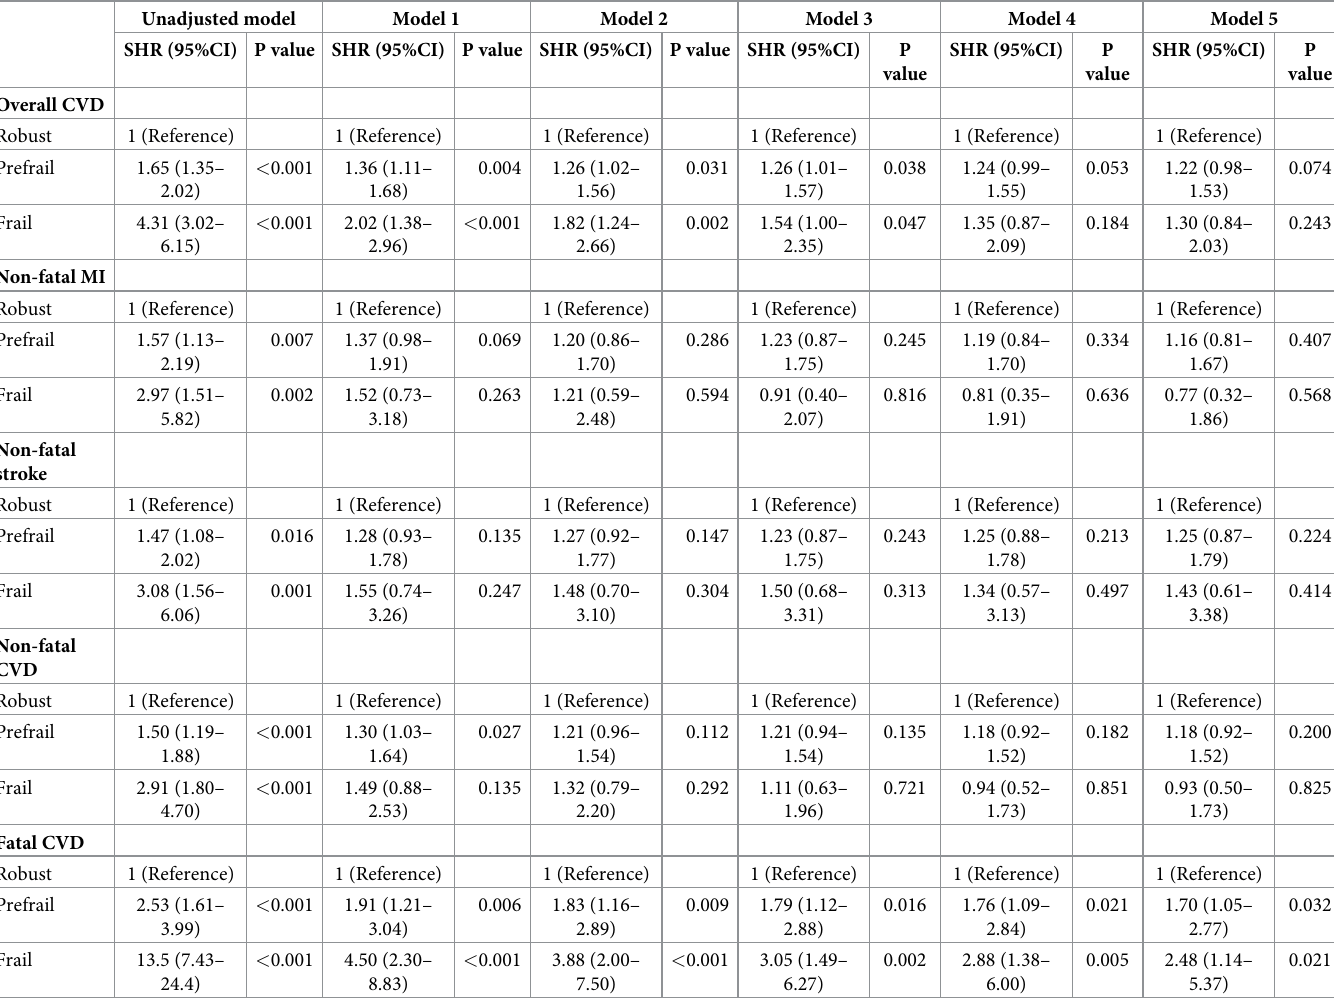
Table 3. Associations between frailty status at baseline and incidence of CVD